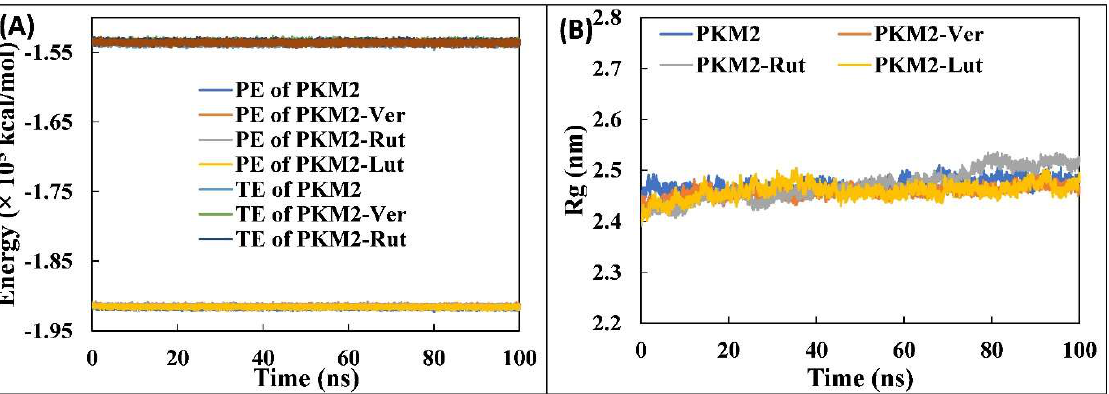
Figure 4. ( A ) Potential and total energy of PKM2 and its complexes with Ver, Rut, and Lut. ( B ) Radius of gyration (Rg) of PKM2 in the absence and presence of Ver, Rut, and Lut as a function of simulation time. The data presented are averages of three independent simulations.